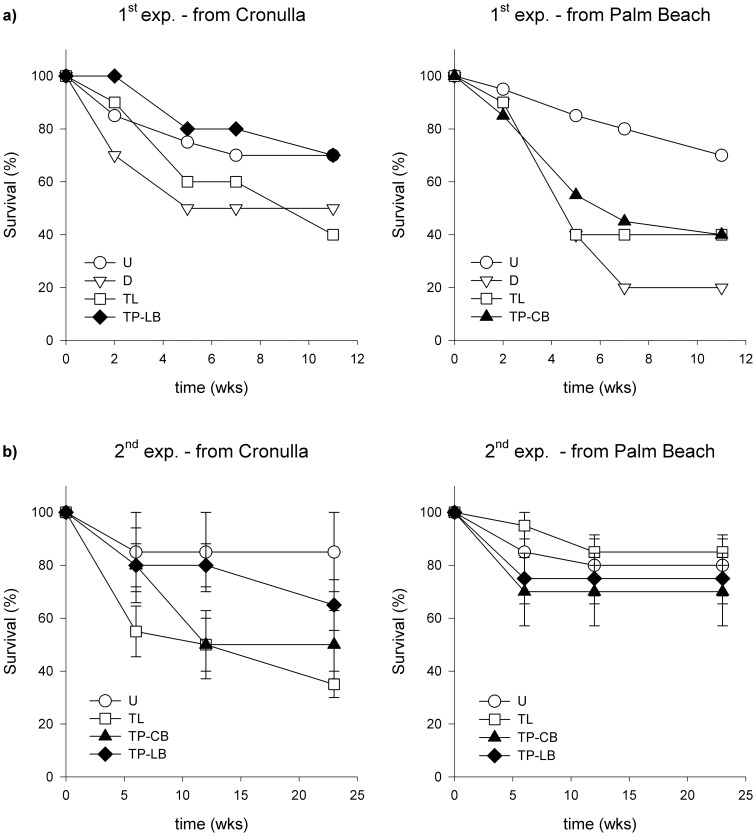
Survival (%) of Phyllospora in the (a) first (total for each site) and (b) second (mean ± S.E.; n = 4) transplant experiments from Cronulla and Palm Beach to Long Bay and Cape Banks respectively.Treatments are Undisturbed (U; white circles), Disturbed (D; white triangles), Translocated (TL; white squares) and Transplanted to Long Bay (TP-LB; black diamonds) or Cape Banks (TP-CB; black triangles).